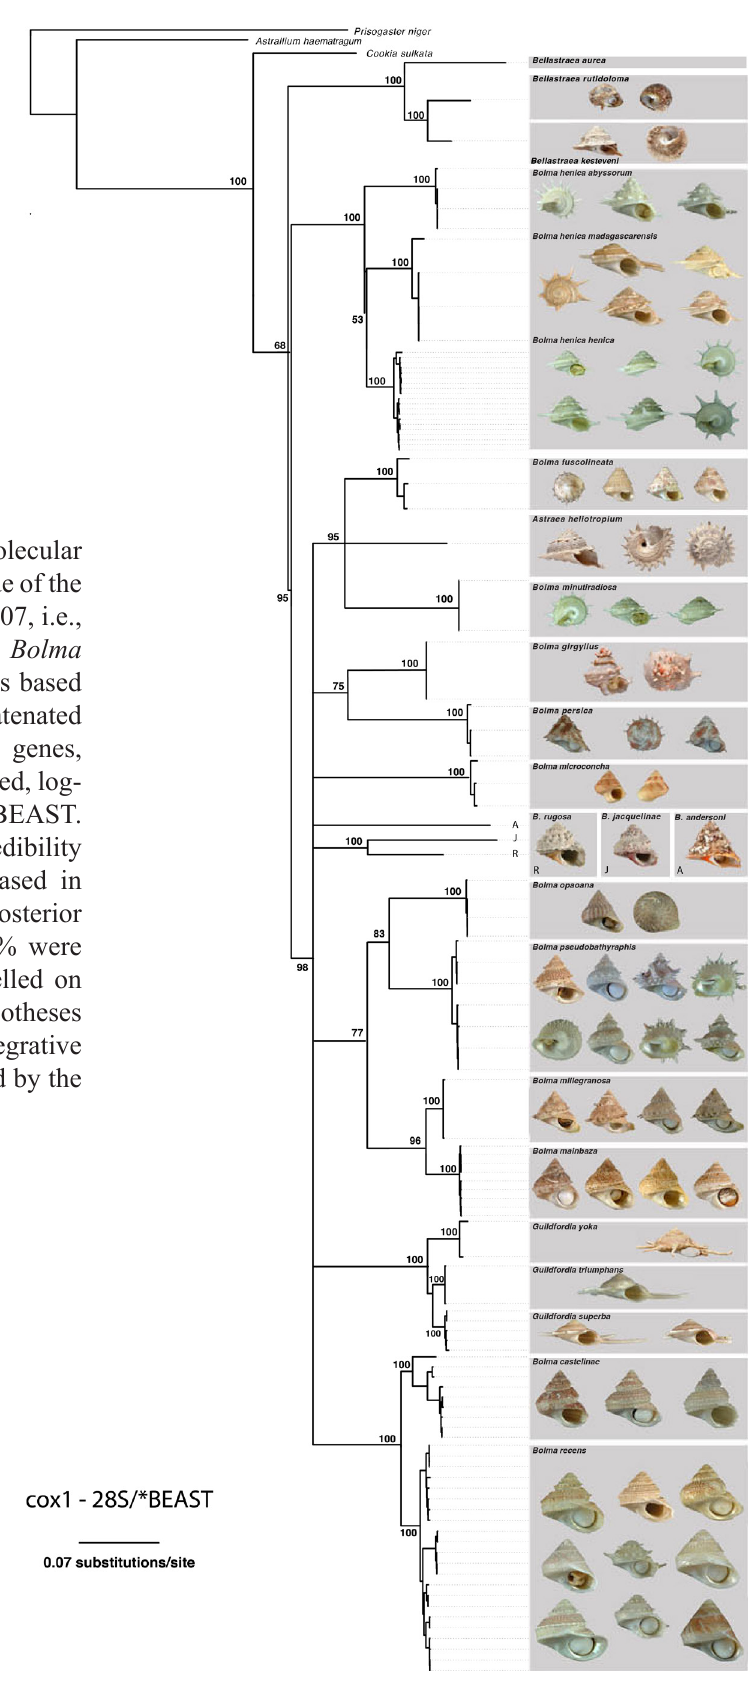
Fig. 4. Shell diversity across the molecular phylogeny of the “deep-water” clade of the subfamily Turbininae (Williams 2007, i.e., the genera Astraea , Bellastraea , Bolma and Guildfordia ). The phylogeny is based on Bayesian analyses of the concatenated sequences from cox1 and 28S genes, incorporating an uncorrelated relaxed, log- normal clock produced using *BEAST. The tree is a maximum clade credibility tree with median node heights based in 9000 trees. Support values are posterior probabilities (PP); branches < 50% were collapsed. Species names are labelled on the right-hand side. Species hypotheses previously delineated by the integrative taxonomy approach are highlighted by the grey